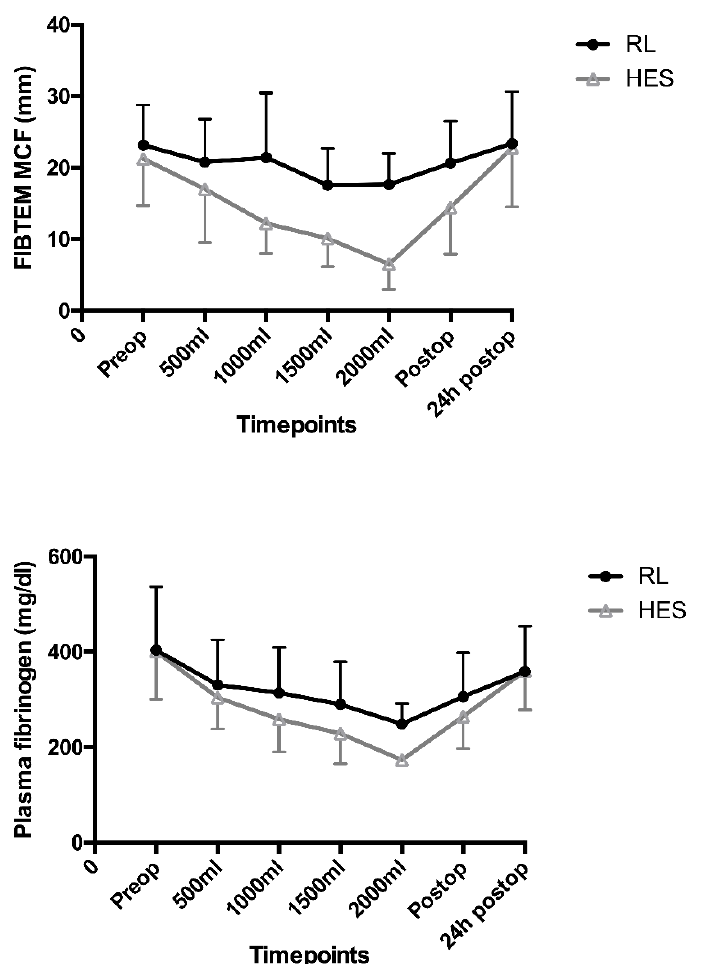
Figure 3. Time course of FIBTEM MCF results and plasma fibrinogen levels preoperatively (RL/HES: n = 25) and after 500 mL (RL: n = 23, HES: n = 24), 1000 mL (RL: n = 20, HES: n = 18), 1500 mL (RL: n = 11, HES: n = 8), and 2000 mL (RL: n = 6, HES: n = 2) of study fluid, respectively, as well